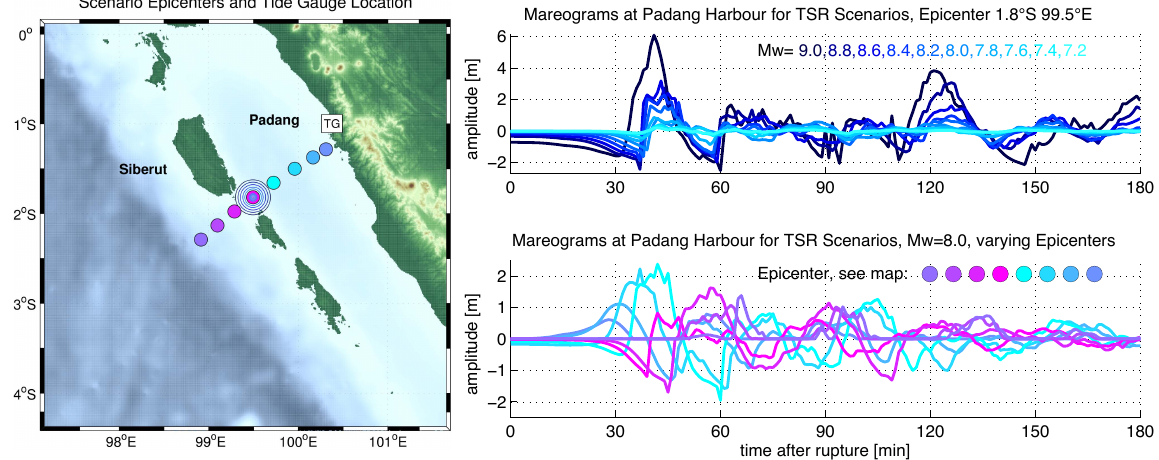
Fig. 14. Influence of the magnitude M w and of the source location on the strength of a tsunami: mareograms at Padang Harbor for TSR- scenarios originating at the same epicentre with different magnitude (above) and with equal magnitude, but different origin (below).